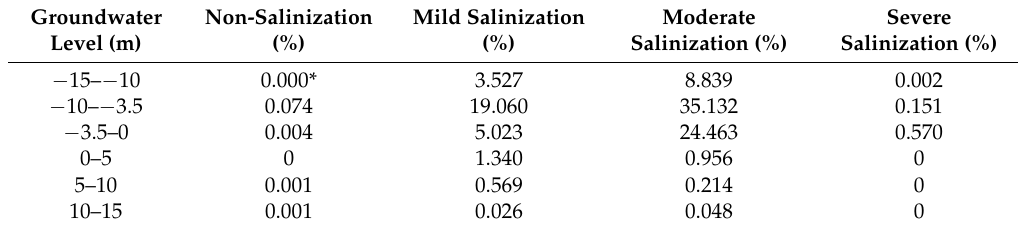
Table 8. Statistical Table of Groundwater Level and Salinized Soil in